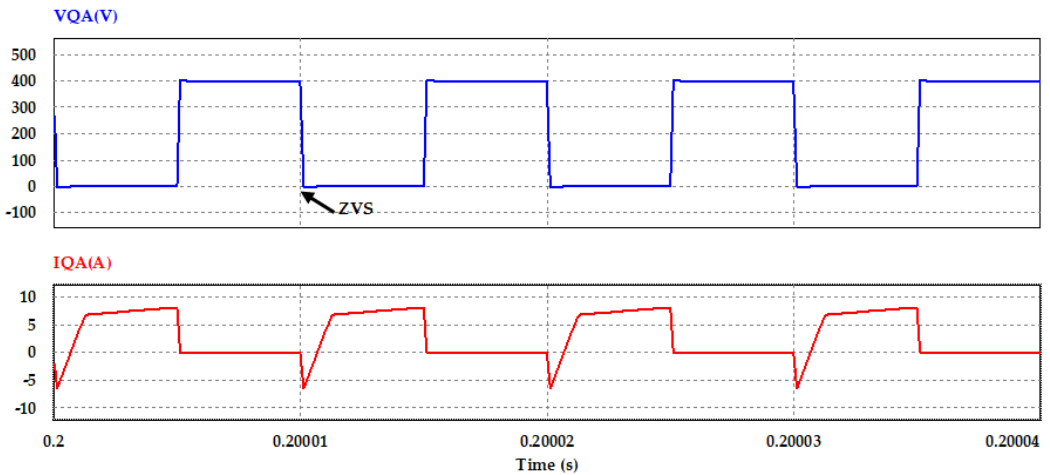
Figure 15. Voltage and current waveforms of switch QA converter primary side at Po = 2 kW.